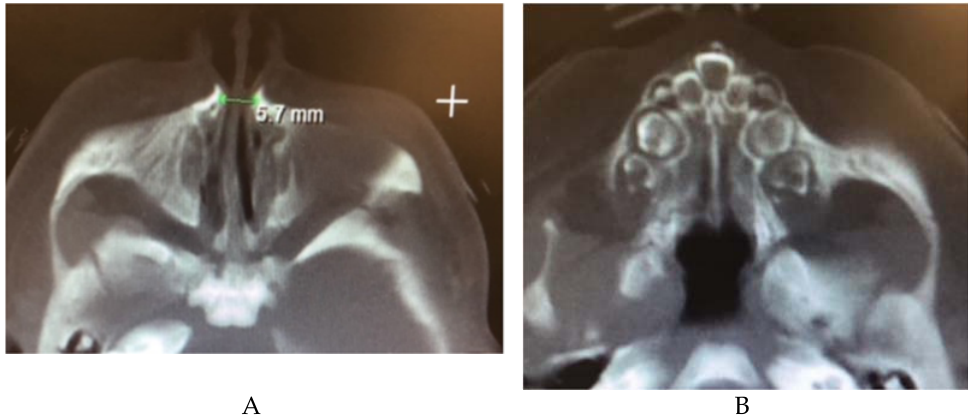
Figure 9. ( A ) CT image showing a narrow pyriform aperture ( B ) CT image showing central megaincisor.